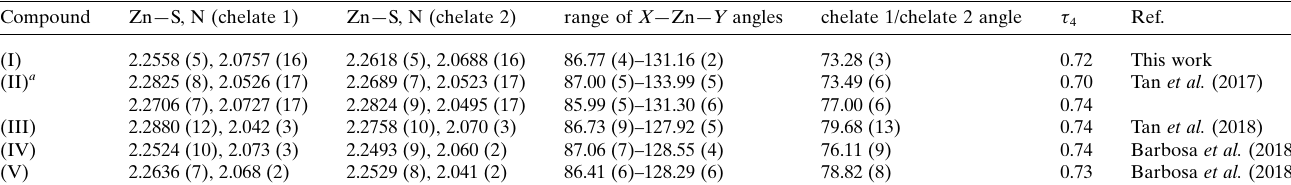
Table 6 A comparison of key geometric parameters (A˚ , (cid:2) ) in structures related to (I).